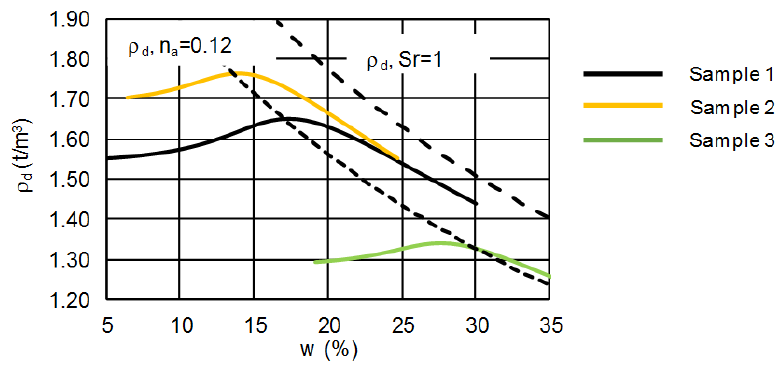
Figure 4. Proctor curves for three typical groups of soils from the top